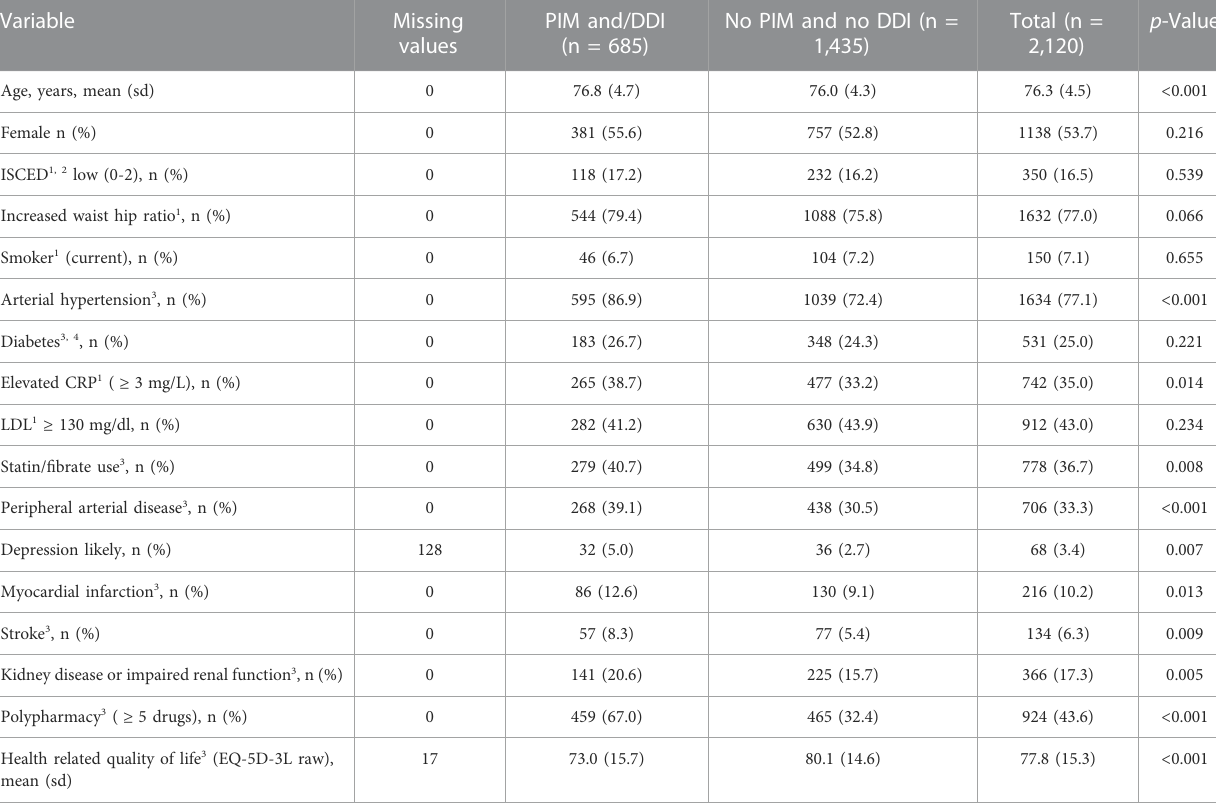
TABLE 1 Baseline characteristics of study participants.